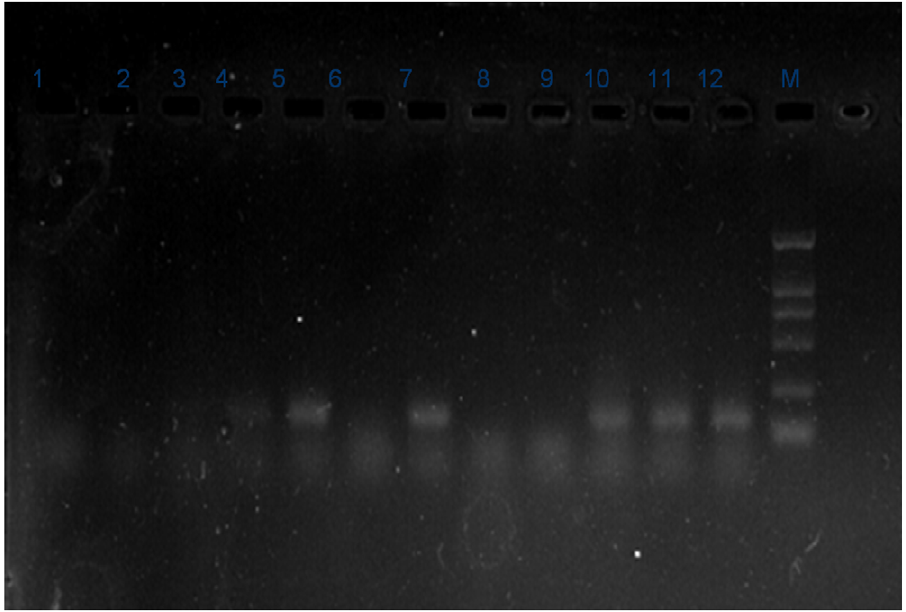
Figure 2. HEV RNA detection by nested RT-PCR. Results for fecal samples. doi:10.1371/journal.pone.0033480.g002 PLoS ONE |